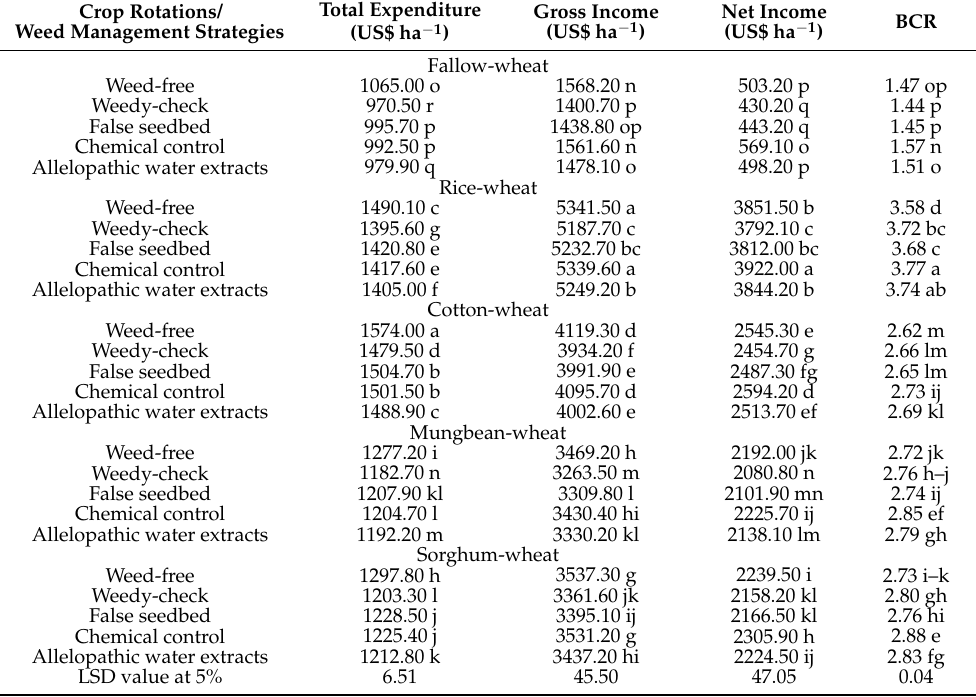
Table 9. Economic analysis of different crop rotations and weed management strategies used in the